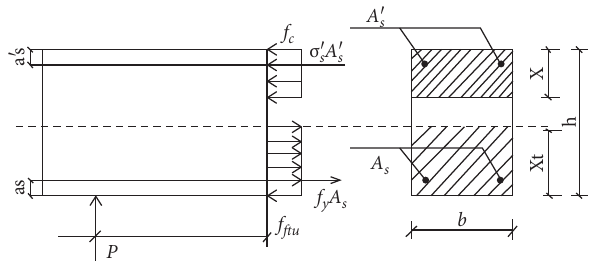
Figure 16: Schematic diagram of predigest calculation.